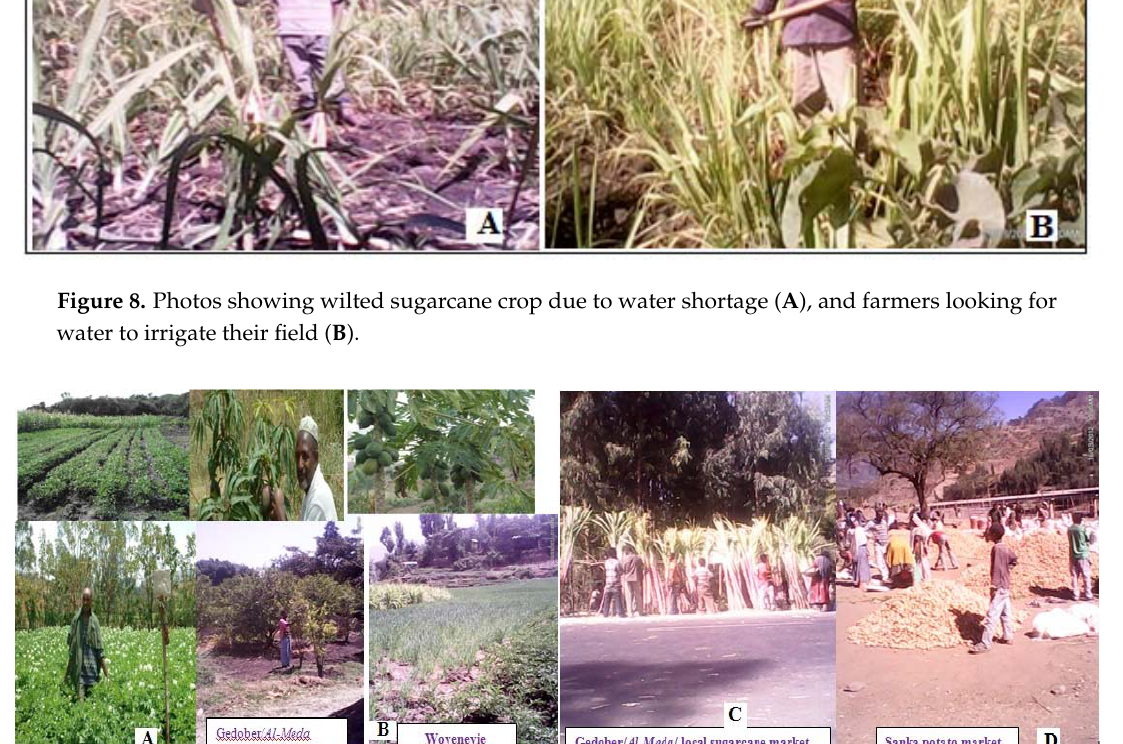
Figure 8. Photos showing wilted sugarcane crop due to water shortage ( A ), and farmers looking for water to irrigate their field ( B ). Figure 9. Photos showing different irrigated crops ( A and B ), and farmers selling sugarcane and potato at a local market ( C and D ), respectively